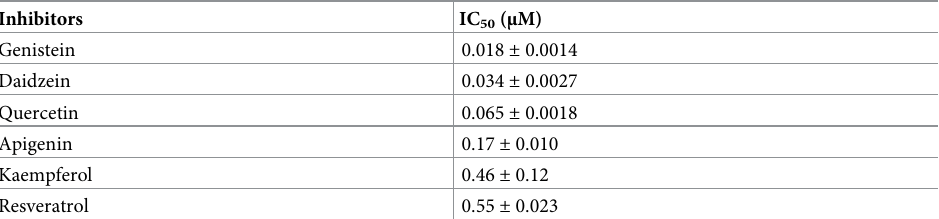
Table 3. Inhibitory effects of polyphenols on aldo-keto reductase (AKR) 2E8